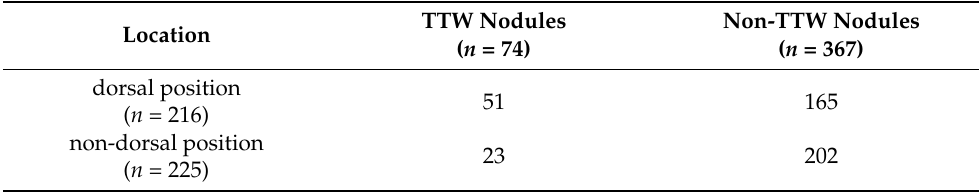
Table 1. Location of TTW nodules and non-TTW nodules in thyroid gland. Location